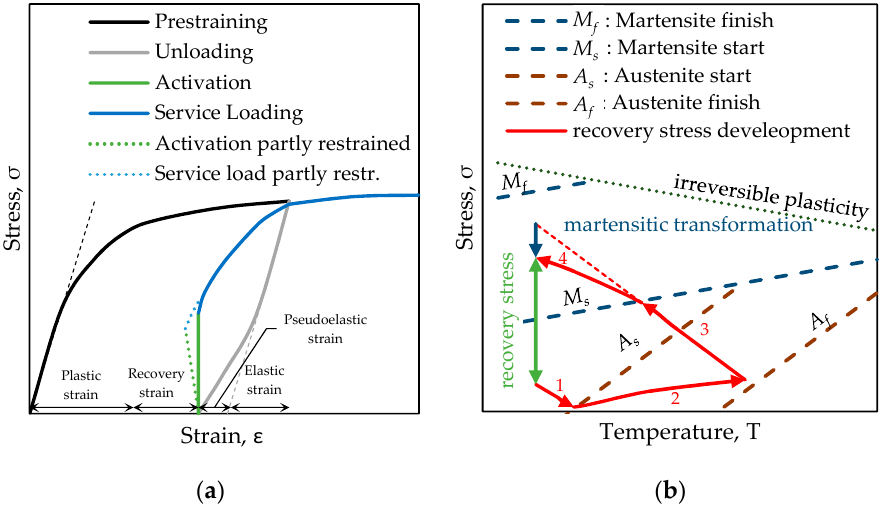
Figure 2. ( a ) Schematic sketch of the stress-strain response during shape memory alloy (SMA)